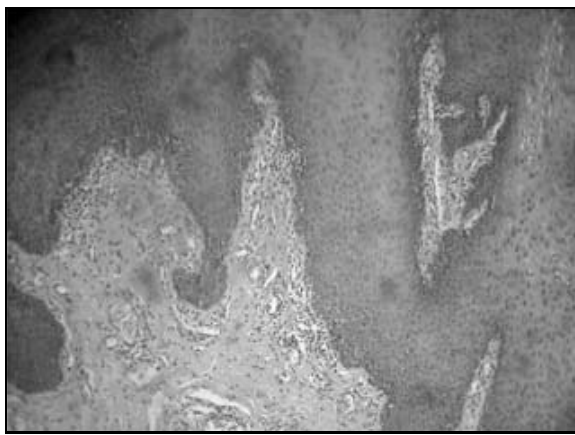
Figura 5 – Áreas hiperplásicas no epitélio emitindo projeções para conjuntivo, algumas dessas semelhantes a “taco de golfe” (HE